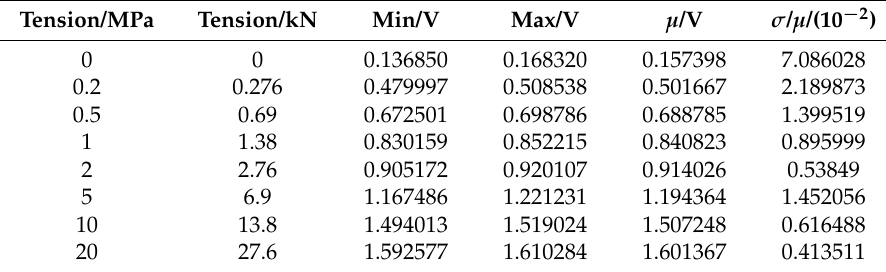
Figure 14. Mean of the focused signals based on times reversal. Table 4. Five test’s